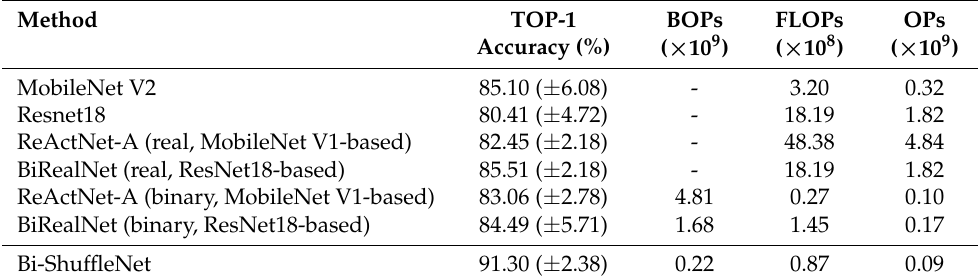
Figure 4. Classification performance on Magnetic Tile and NEU datasets. Table 1. Coarse-grained defect detection performance on Magnetic Tile.